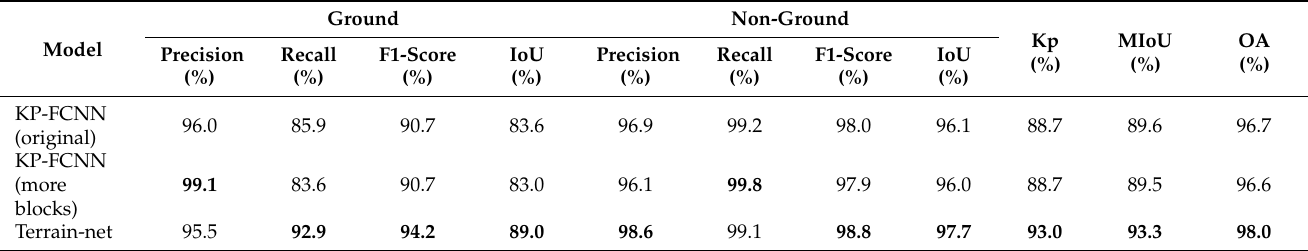
Table 4. The effectiveness of self-attention